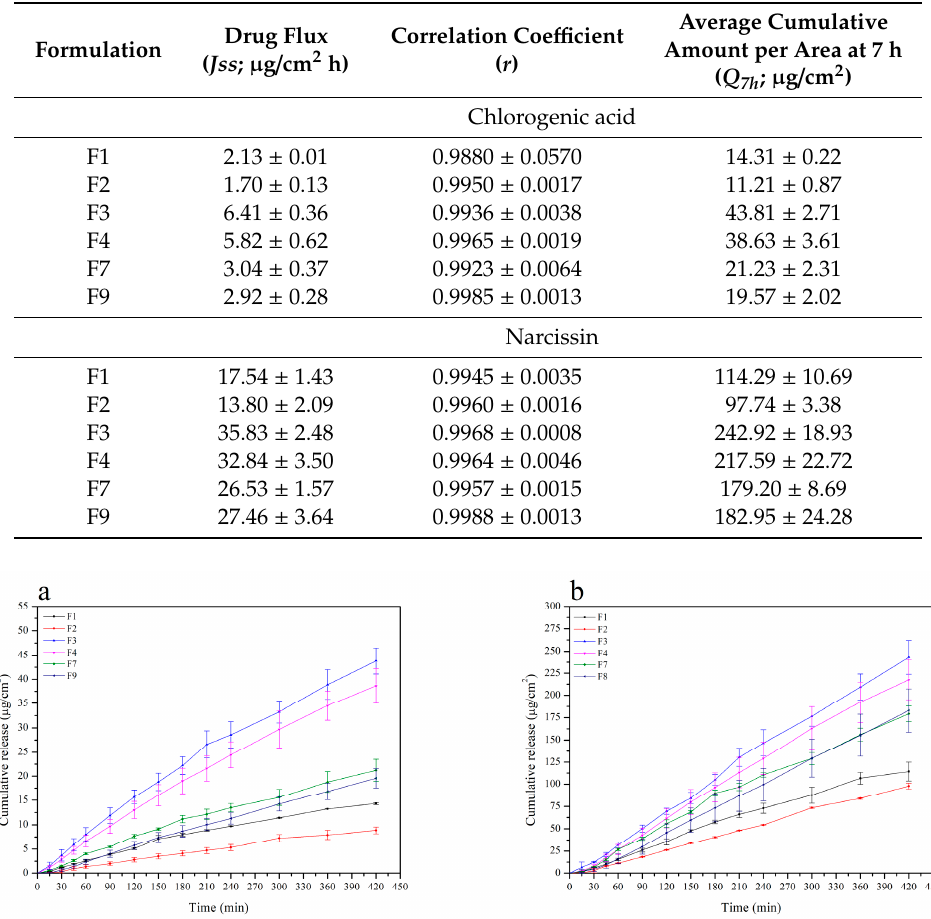
Table 6. The drug flux and the average cumulative amount per area during dissolution studies of HPMC-based hydrogel with chitosan delivery system with Calendulae flos lyophilized extract. Formulation